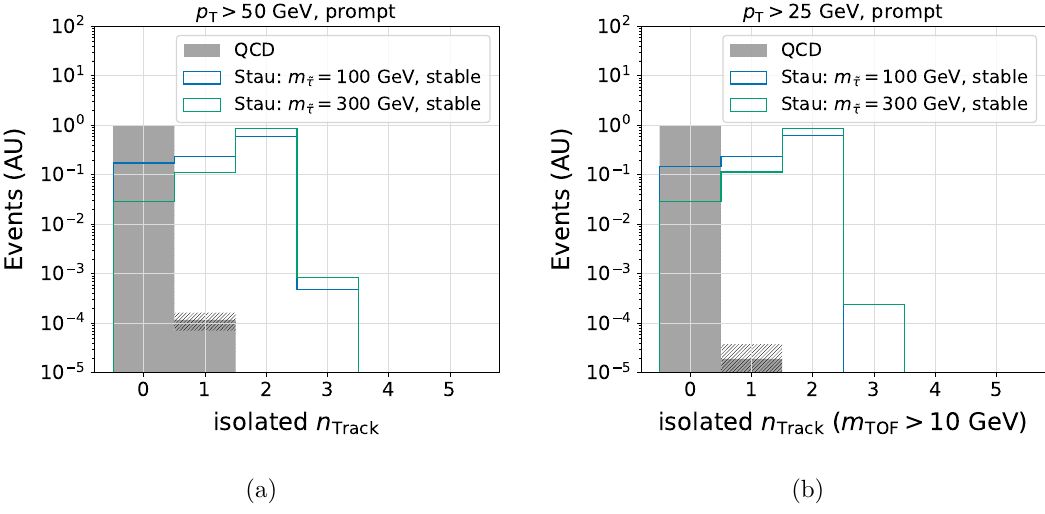
Figure 24. The number of p T > 50 GeV isolated tracks (a) and m TOF > 25 GeV, isolated p T > 25 GeV tracks (b) per event for minimum bias QCD and representative HSCP signal samples with pile-up 200. Slashed bands on the QCD distribution represent the statistical uncertainty.